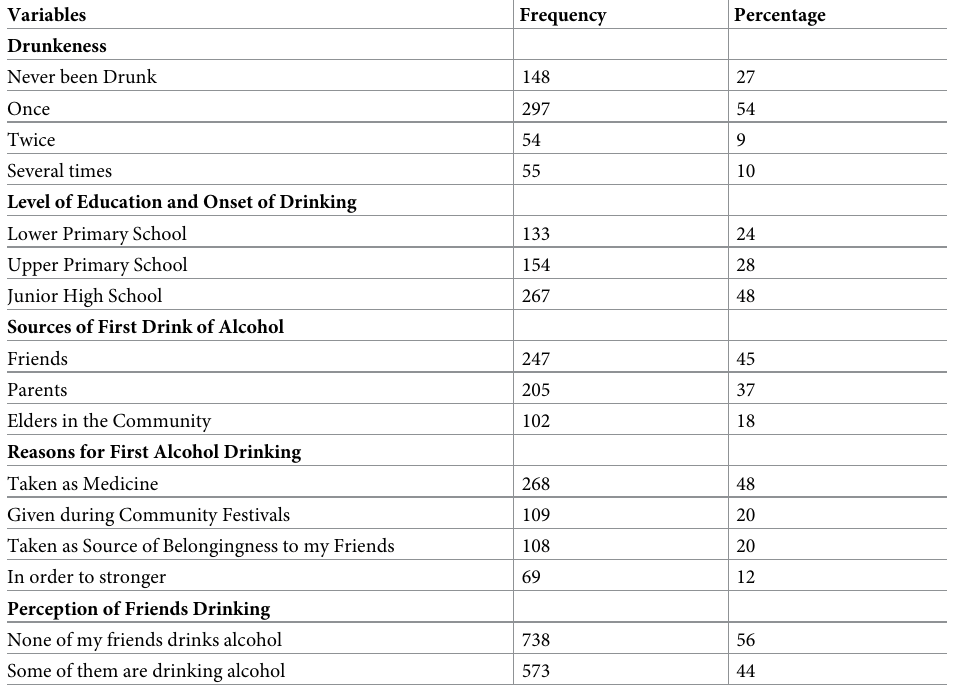
Table 1. Drunkeness, sources of alcohol and reasons for alcohol